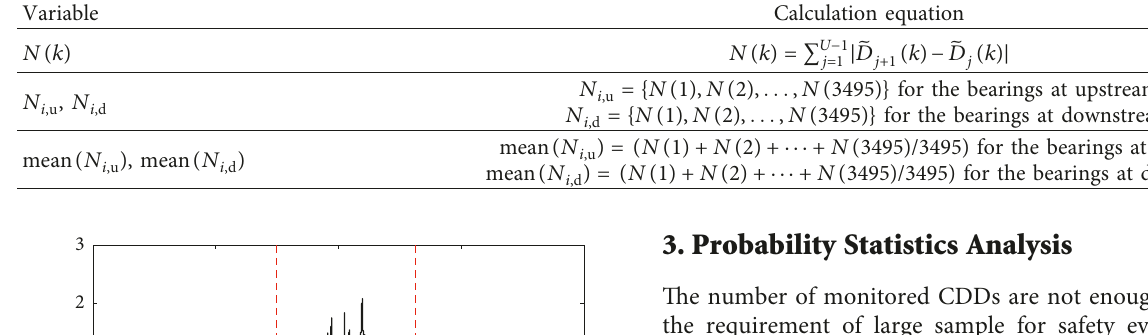
N ( N ) , and mean ( N ) . i, u , i, d , mean i, u i, d